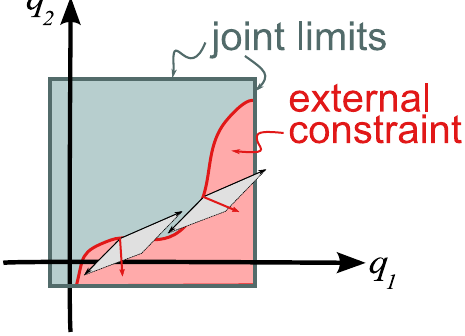
Figure 10. Equilibrium conditions for a asymmetric finger touch- ing a general constraint. Constraint inner normal (red) is directed into the superimposed feasible torque